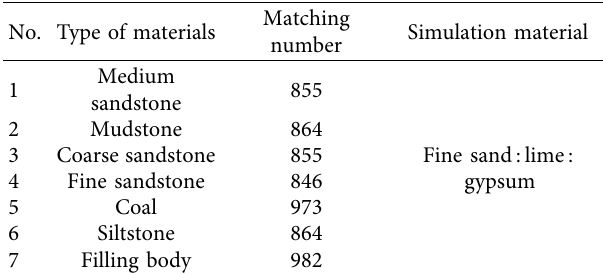
Table 2: Proportion of